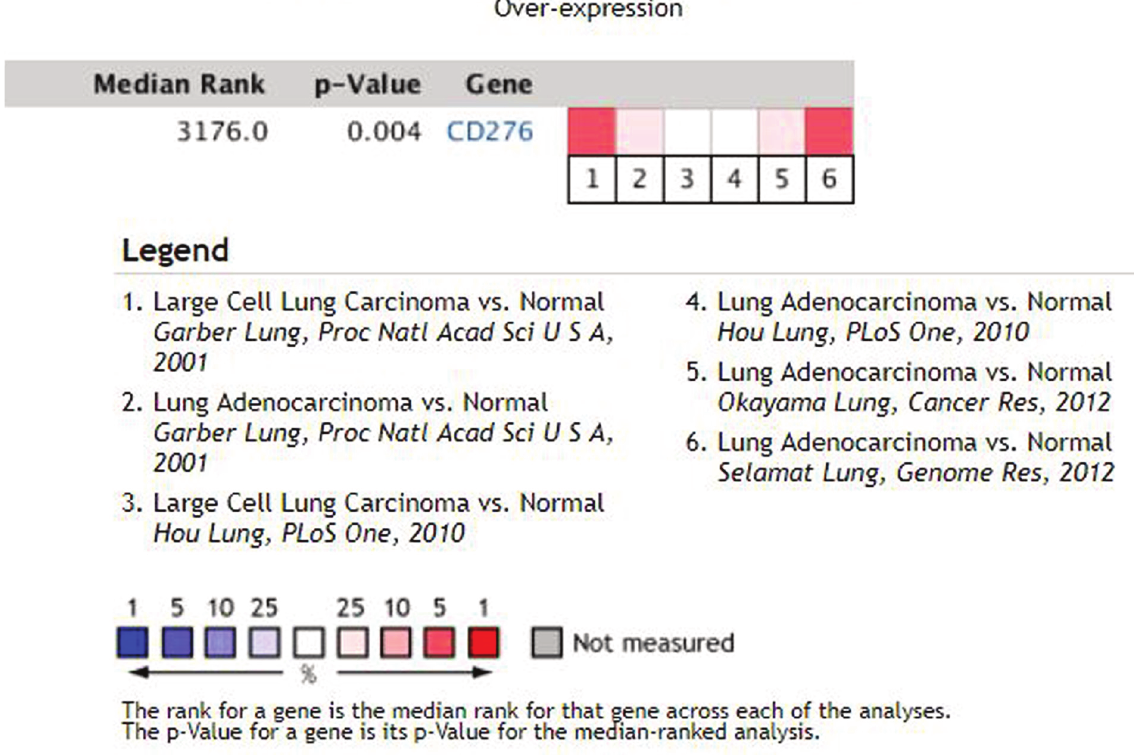
Figure 3: Differential expression of CD276 in NSCLC and normal lung